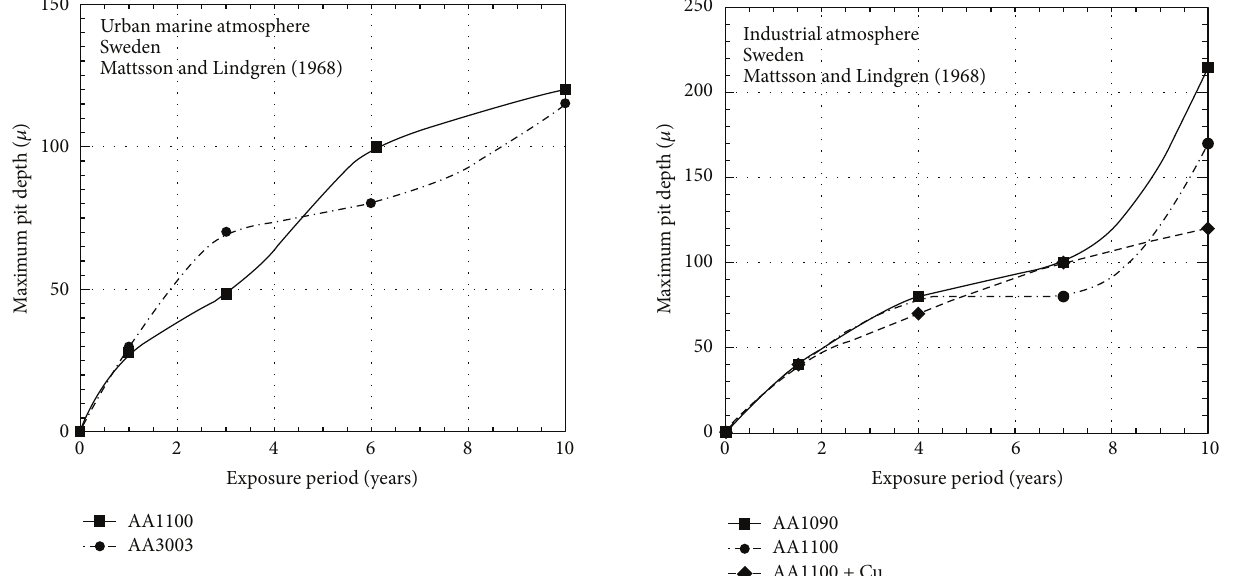
Figure 2: Data for maximum pit depth of AA1100 aluminium exposed in urban marine atmospheric environment showing the trends for pit depth are bimodal. The changeover to mode 2 occurs at about 3 and 7 years of exposure for AA1100 and AA3003, respectively. Data from Mattsson and Lindgren [13].